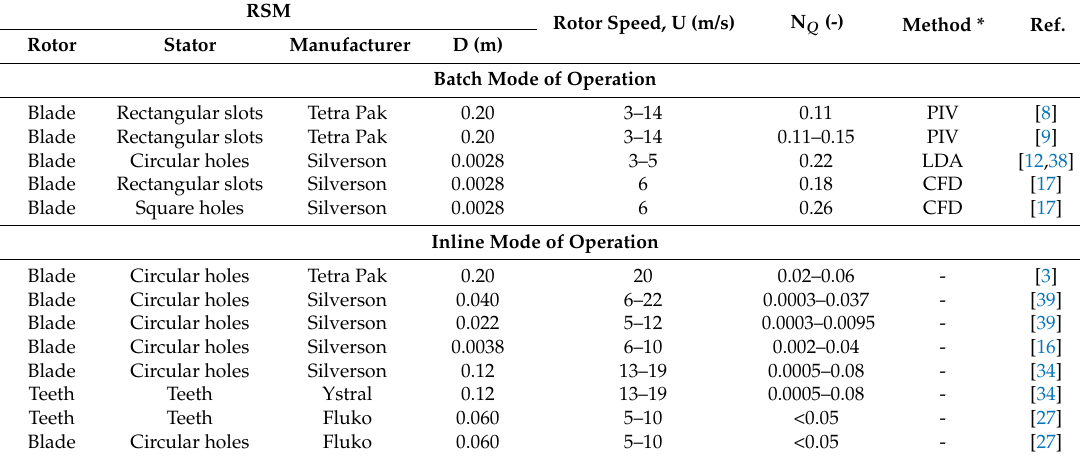
Table 2. Flow numbers ( N Q ) for a number of batch and continuous mode